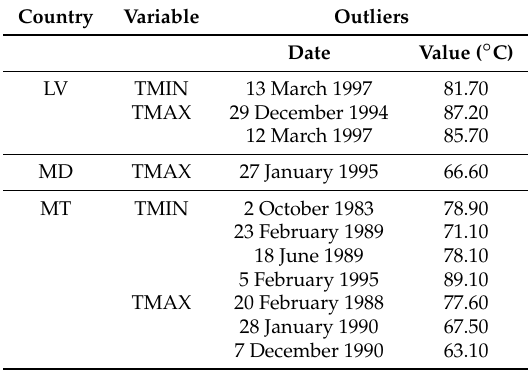
Figure A1. Example of outliers that have been detected in the reference maximum temperature from Malta (MT) on 28 January and 7 December 1990, and removed form the original dataset. Table A2. Detail of the outliers removed from the reference weather stations, and TMAX and TMIN time series in the studied interval (January 1980 to December